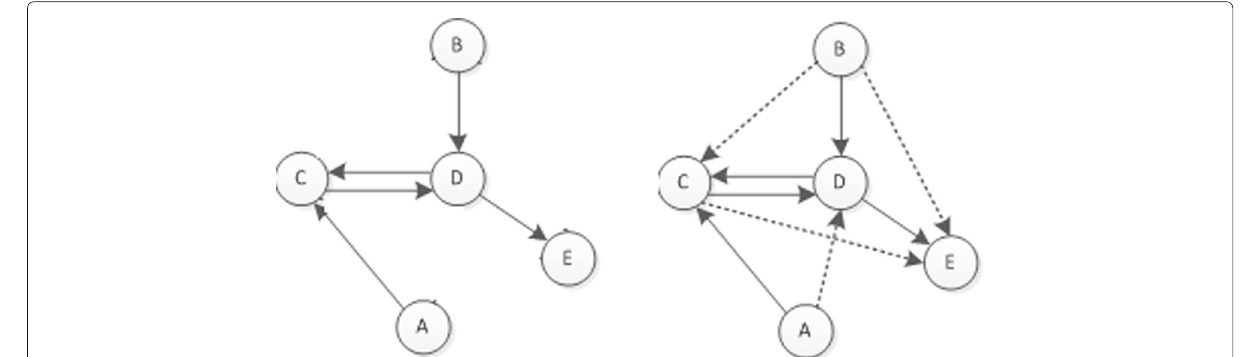
Fig. 2 An example of trust